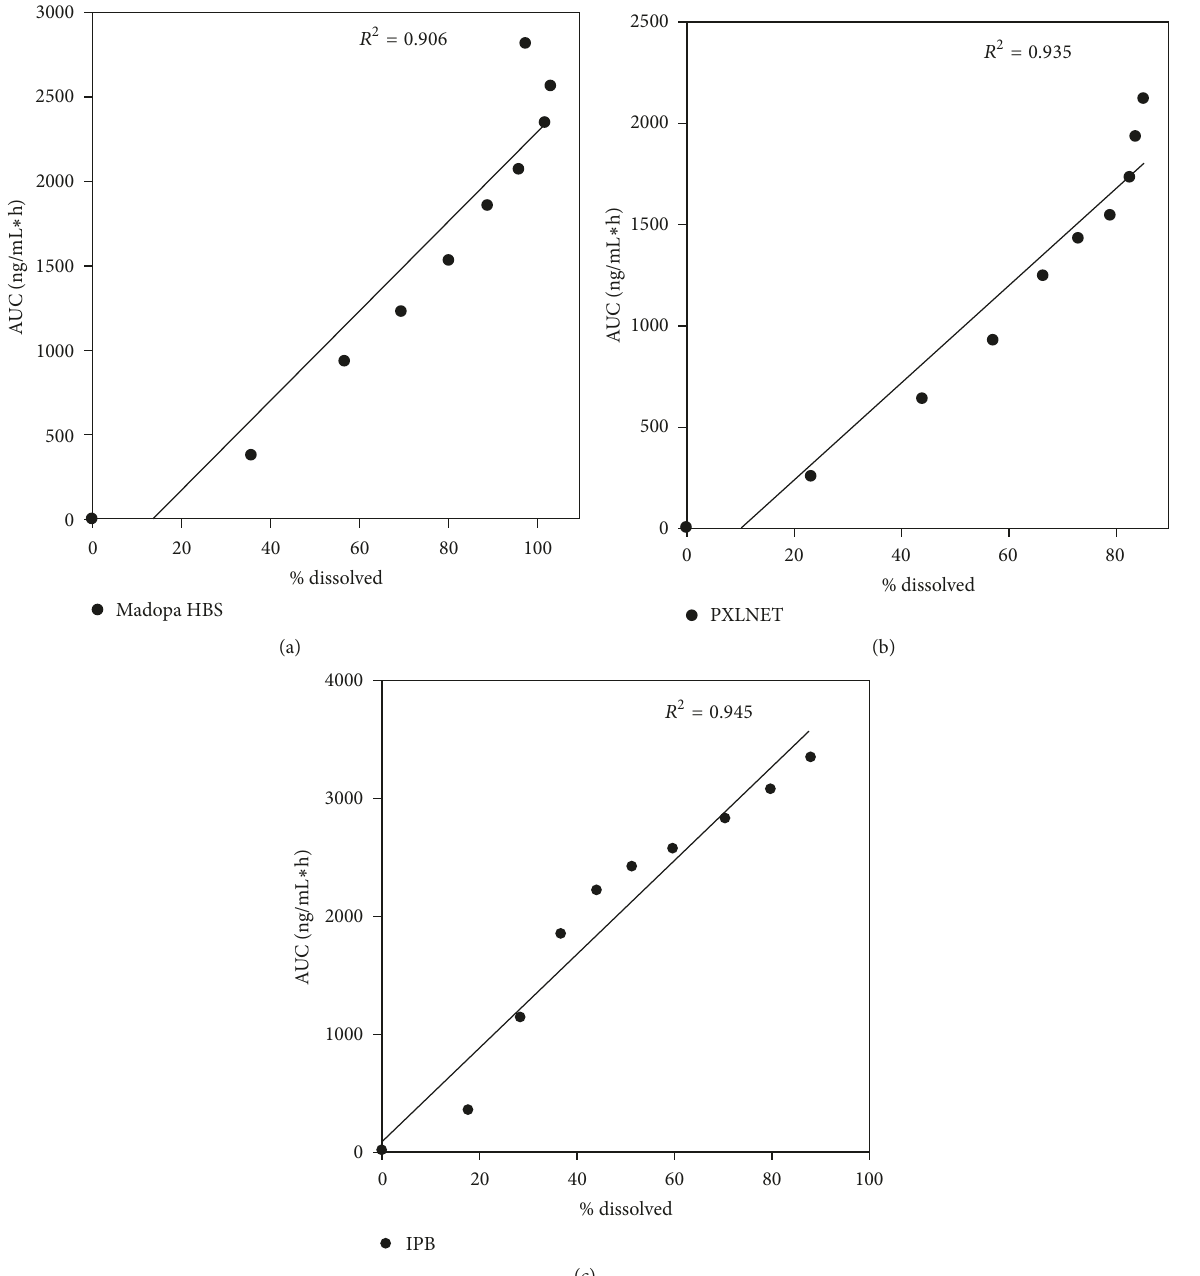
Figure 10: Linear regression multiple-level C IVIVC correlation models for (a) Madopar HBS capsules; (b) PXLNET matrices; and (c) IPB